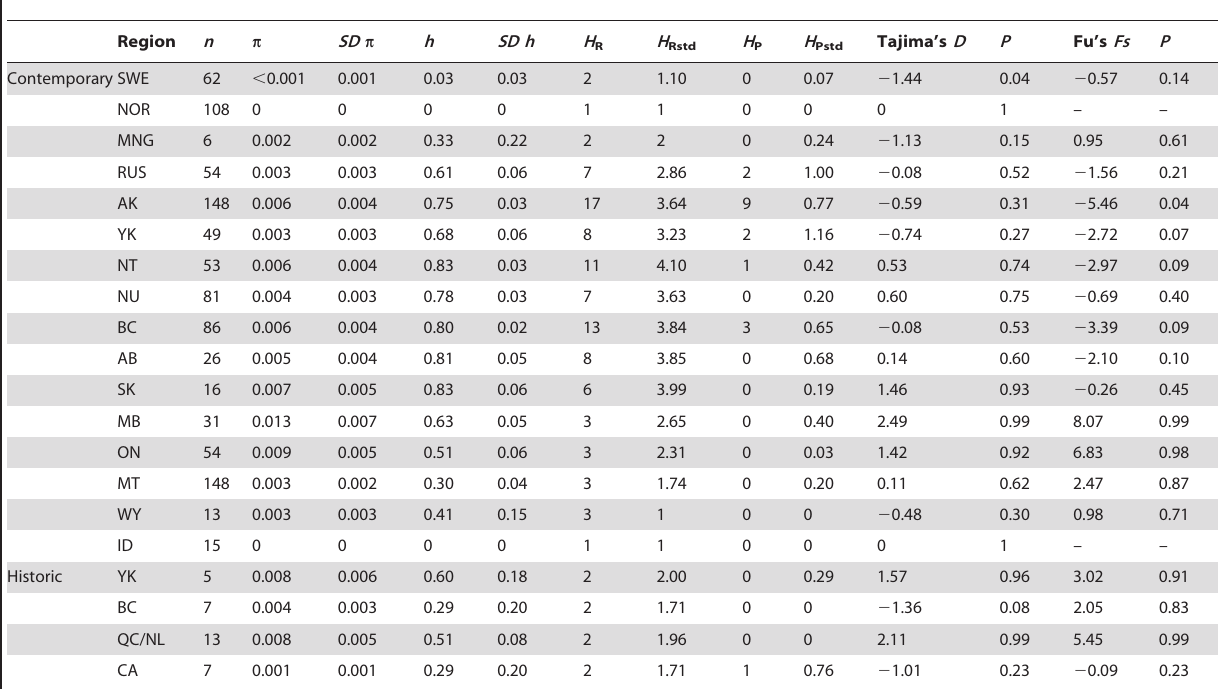
Table 1. MtDNA nucleotide diversity ( p ), haplotype diversity ( h ), haplotype richness ( H R ), private haplotype ( H P ) counts, their standard deviations ( SD p , SD h , H Rstd , and H Pstd ) and standardized to the smallest sample size for both contemporary ( g =6)